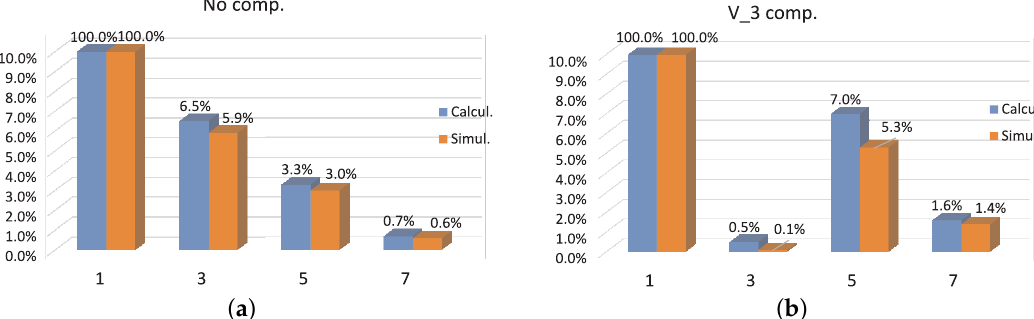
Figure 8. First three higher harmonics comparison in the over-modulation ( m I = 1.2): ( a ) Without compensation and ( b ) With third harmonic